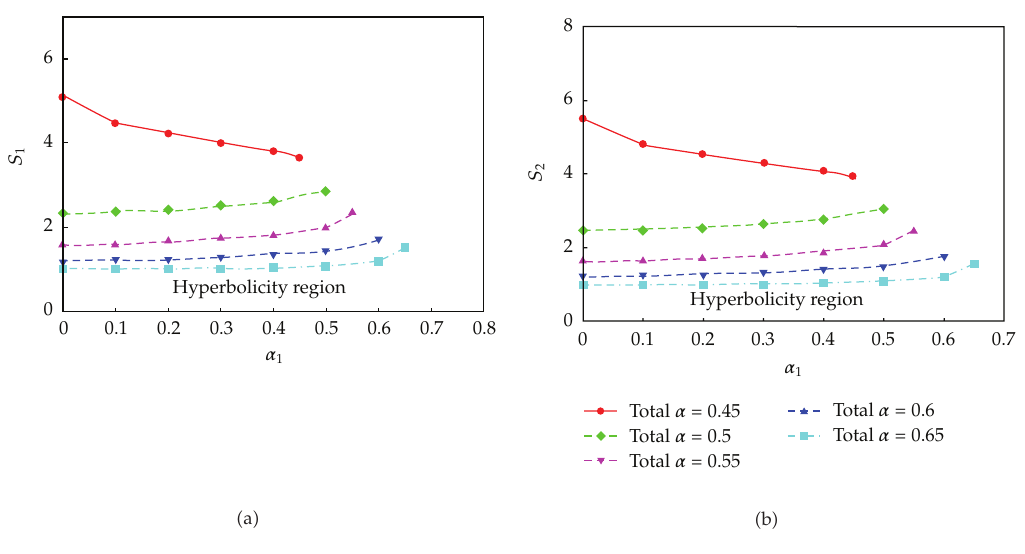
Figure 11: Stability criteria of the one-dimensional two-fluid-IATE model with momentum flux parameters for (cid:2) a (cid:3) S 1 and (cid:2) b (cid:3) S 2